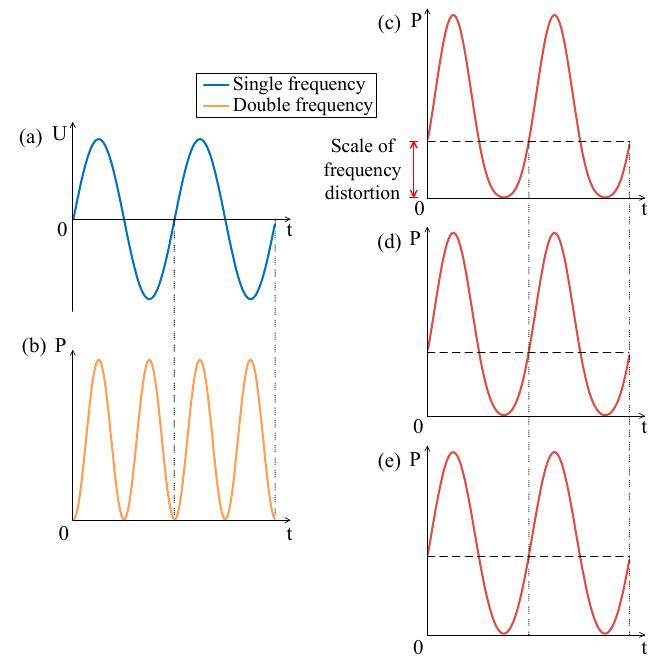
Figure 5. ( a ) AC excitation with amplitude of 5 V. Electric power with ( b ) AC = 5 V; ( c ) AC = 5 V and DC = 7 V; ( d ) AC = 5 V and DC = 9 V; ( e ) AC = 5 V and DC = 20